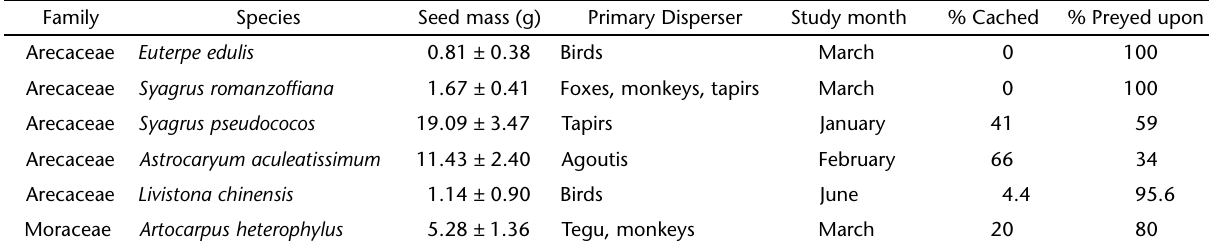
Table I. Characteristics of the seed species used in the experiments and proportion of seeds cached and preyed upon by red-rumped agoutis, D. leporina , at Anchieta Island, Brazil.